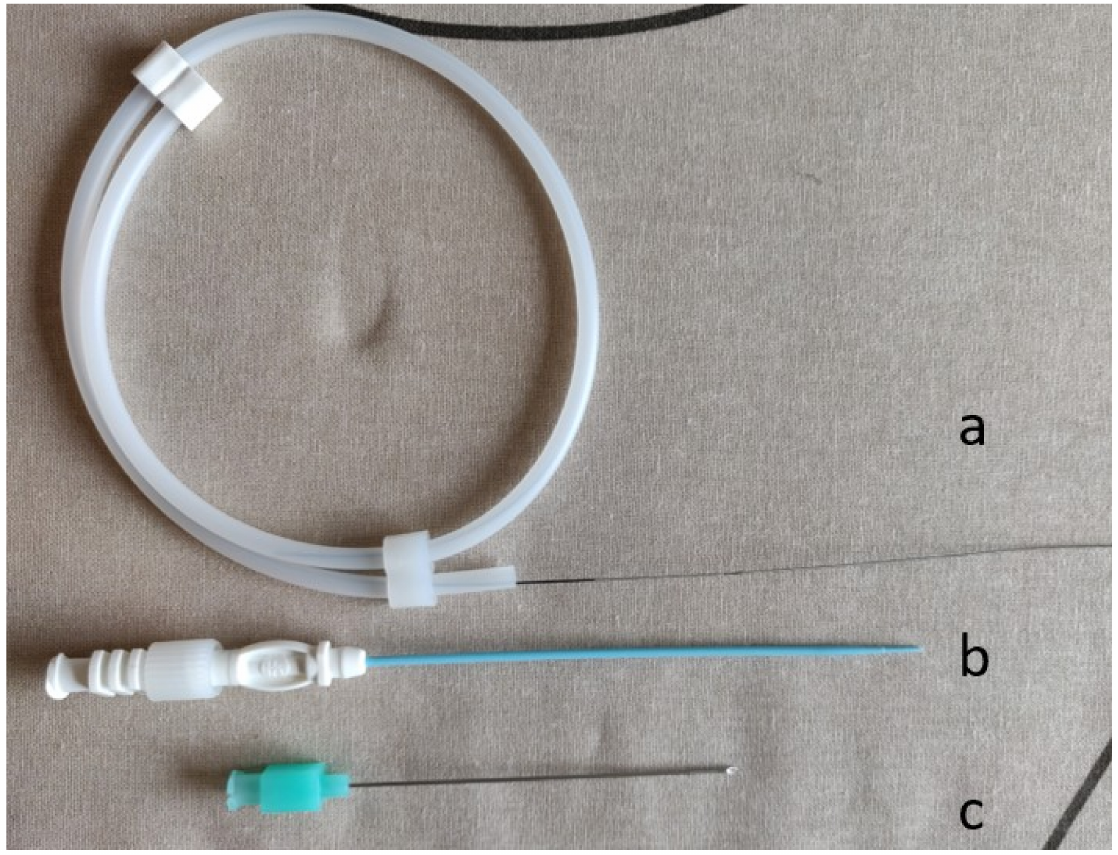
Figure 2. Micropunture system. micropuncture needle (21